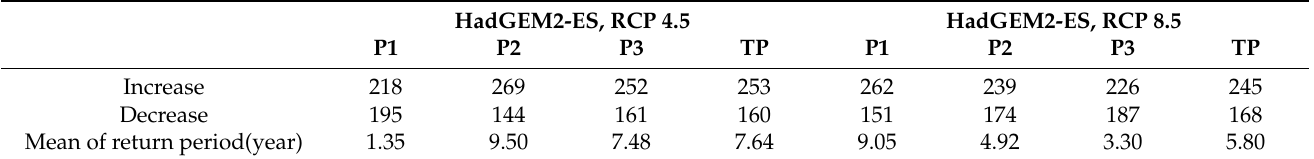
Table 4. The number of river basins with changes in the estimated design frequency considering climate change scenarios (HadGEM2-ES). HadGEM2-ES, RCP 4.5 HadGEM2-ES, RCP